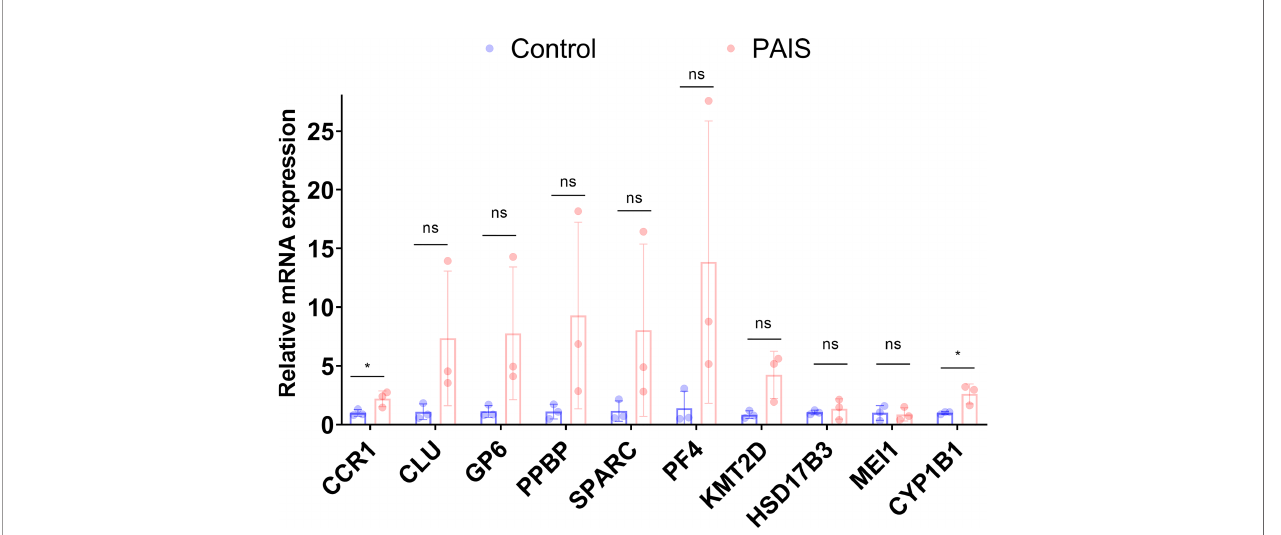
FIGURE 8 | RNA expression of genes of interest were measured in partial androgen insensitivity syndrome (PAIS) and healthy samples. RNA expression of CCR1, PPBP, PF4, CLU, KMT2D, GP6, SPARC, CYP1B1, HSD17B3, and MEI1 was measured. p -Values were calculated using a two-sided unpaired Student ’ s t-test. * p < 0.05; ns, not signi fi